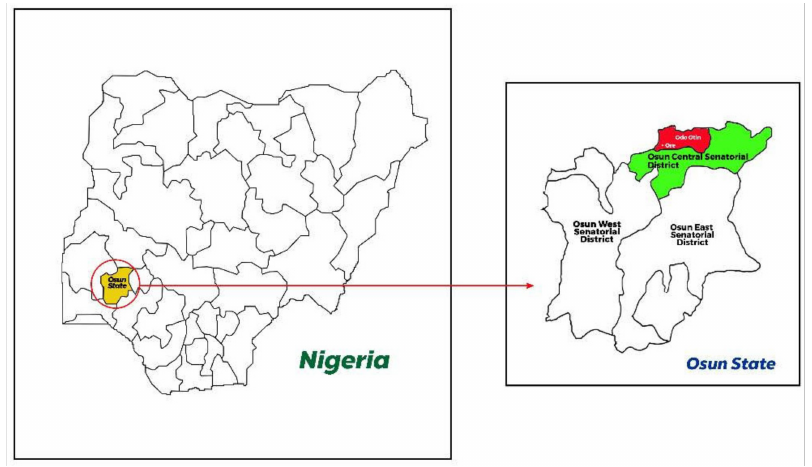
Figure 1. Map of Osun State (yellow in left map), Nigeria showing Ore community in Odo-Otin Local Government (red in right map) where the study was carried out. This community belongs to Osun Central Senatorial District (green in right